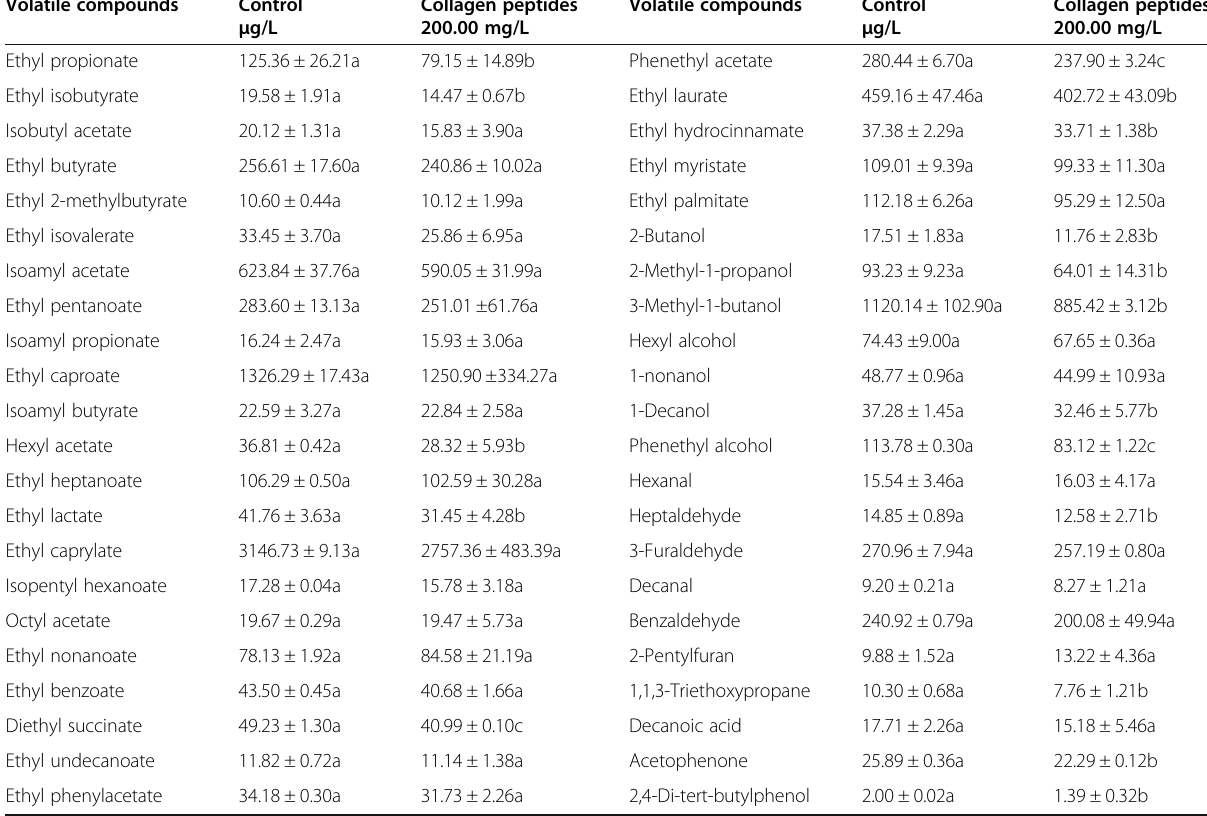
Table 3 Effect of CPs on the content of volatile compounds in light-flavor types baijiu as determined by HS-SPME-GC-MS Volatile